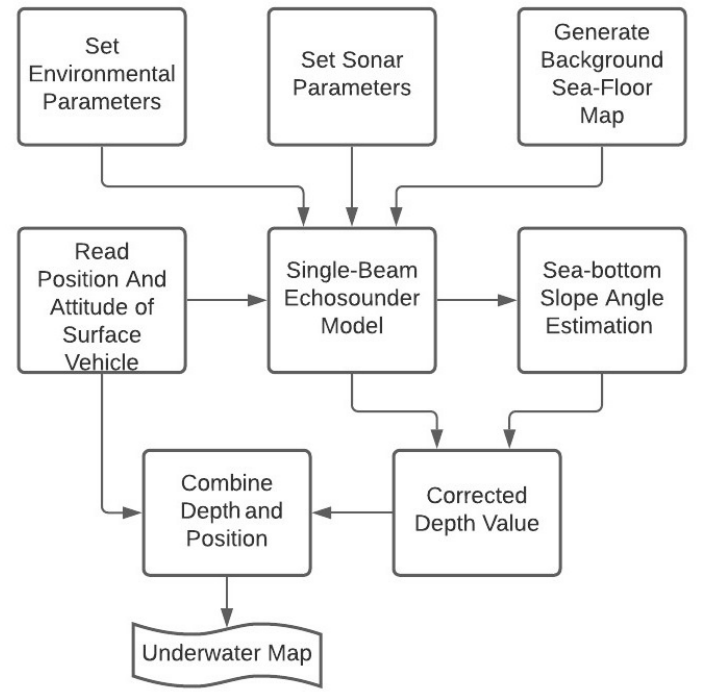
Figure 4. Block diagram of the underwater mapping